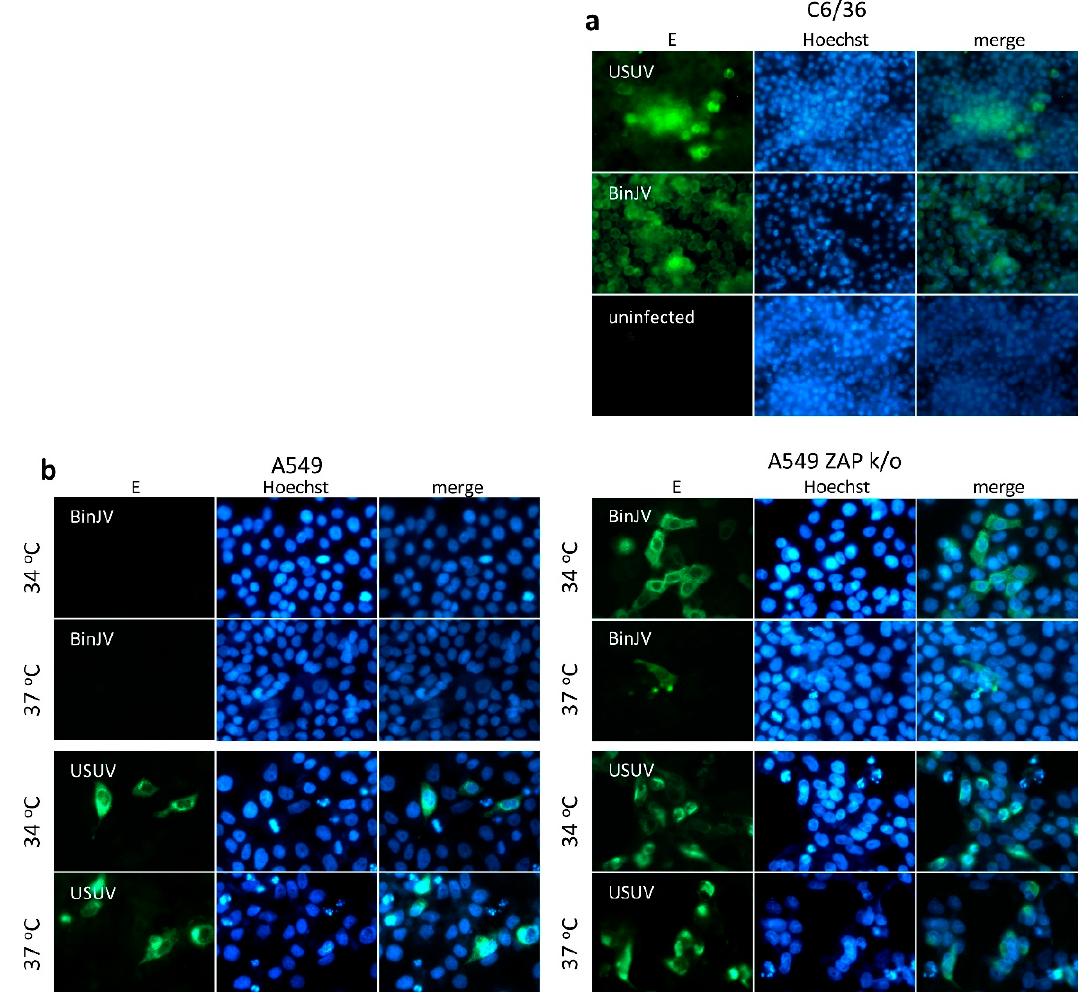
Figure 2. Binjari virus protein expression in human ZAP ko cells. ( a ) C6/36 mosquito cells infected with ISF BinJV and VIF USUV and incubated at 28 ◦ C. ( b ) A549 human lung epithelial carcinoma cells and CRISPR Cas9 ZAP knockout thereof infected with BinJV or USUV and incubated at the indicated temperatures. Four days post infection, cells were fixed and viral envelope proteins were stained with cross reactive BJ-6E6 monoclonal antibodies that detect envelope (E) (green) and nuclei stained with Hoechst 33342 (blue). Micrographs were taken using a Zeiss Axio Observer Z1m inverted microscope with an LD Plan-Neofluar 40 × /0.6 Ph2 korr objective and are representative images from one of three biological repeat experiments, see Figure S1 for additional images.